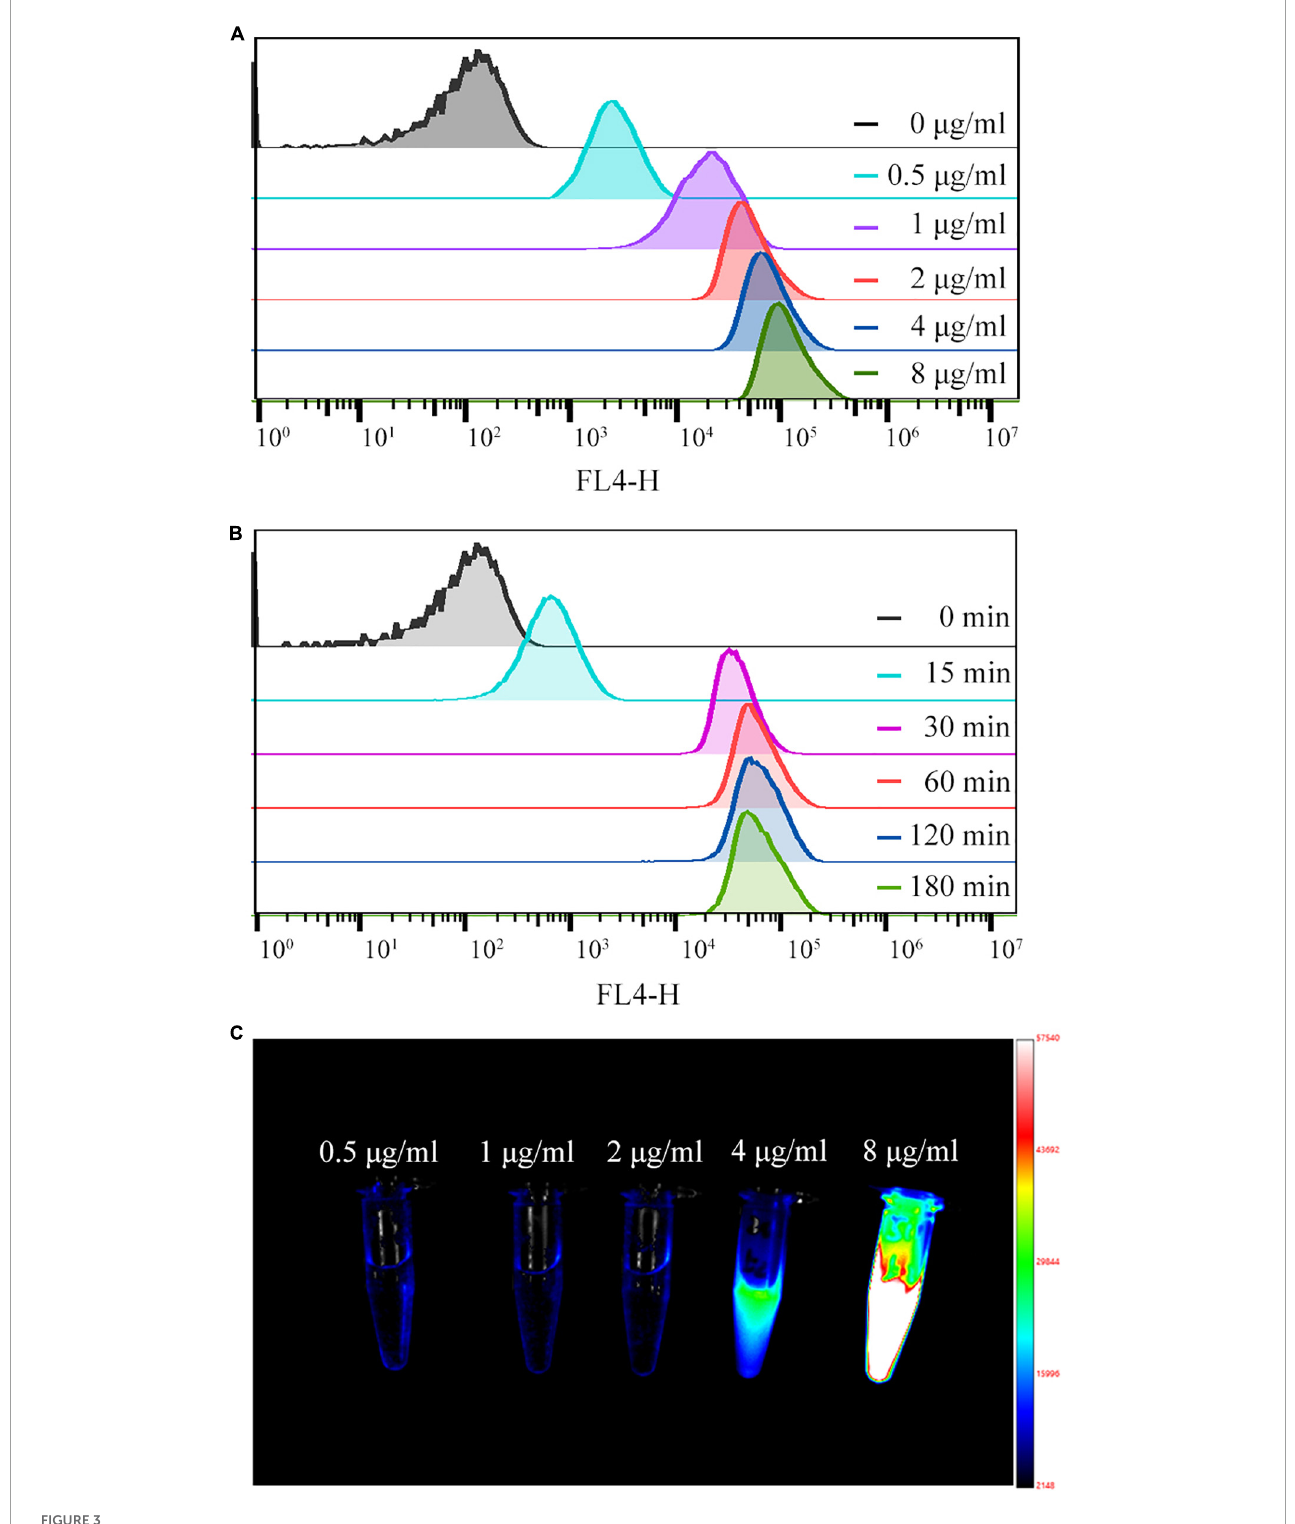
FIGURE3 (A,B) Quantification of fluorescence intensity by flow cytometry for different concentrations of Cy5.5 dye (0.5–8 µ g/mL) and for different labeling times (15–180 min). (C) NIR-I fluorescence image of the supernatant of Staphylococcus aureus after co-culture with different concentrations of Cy5.5.